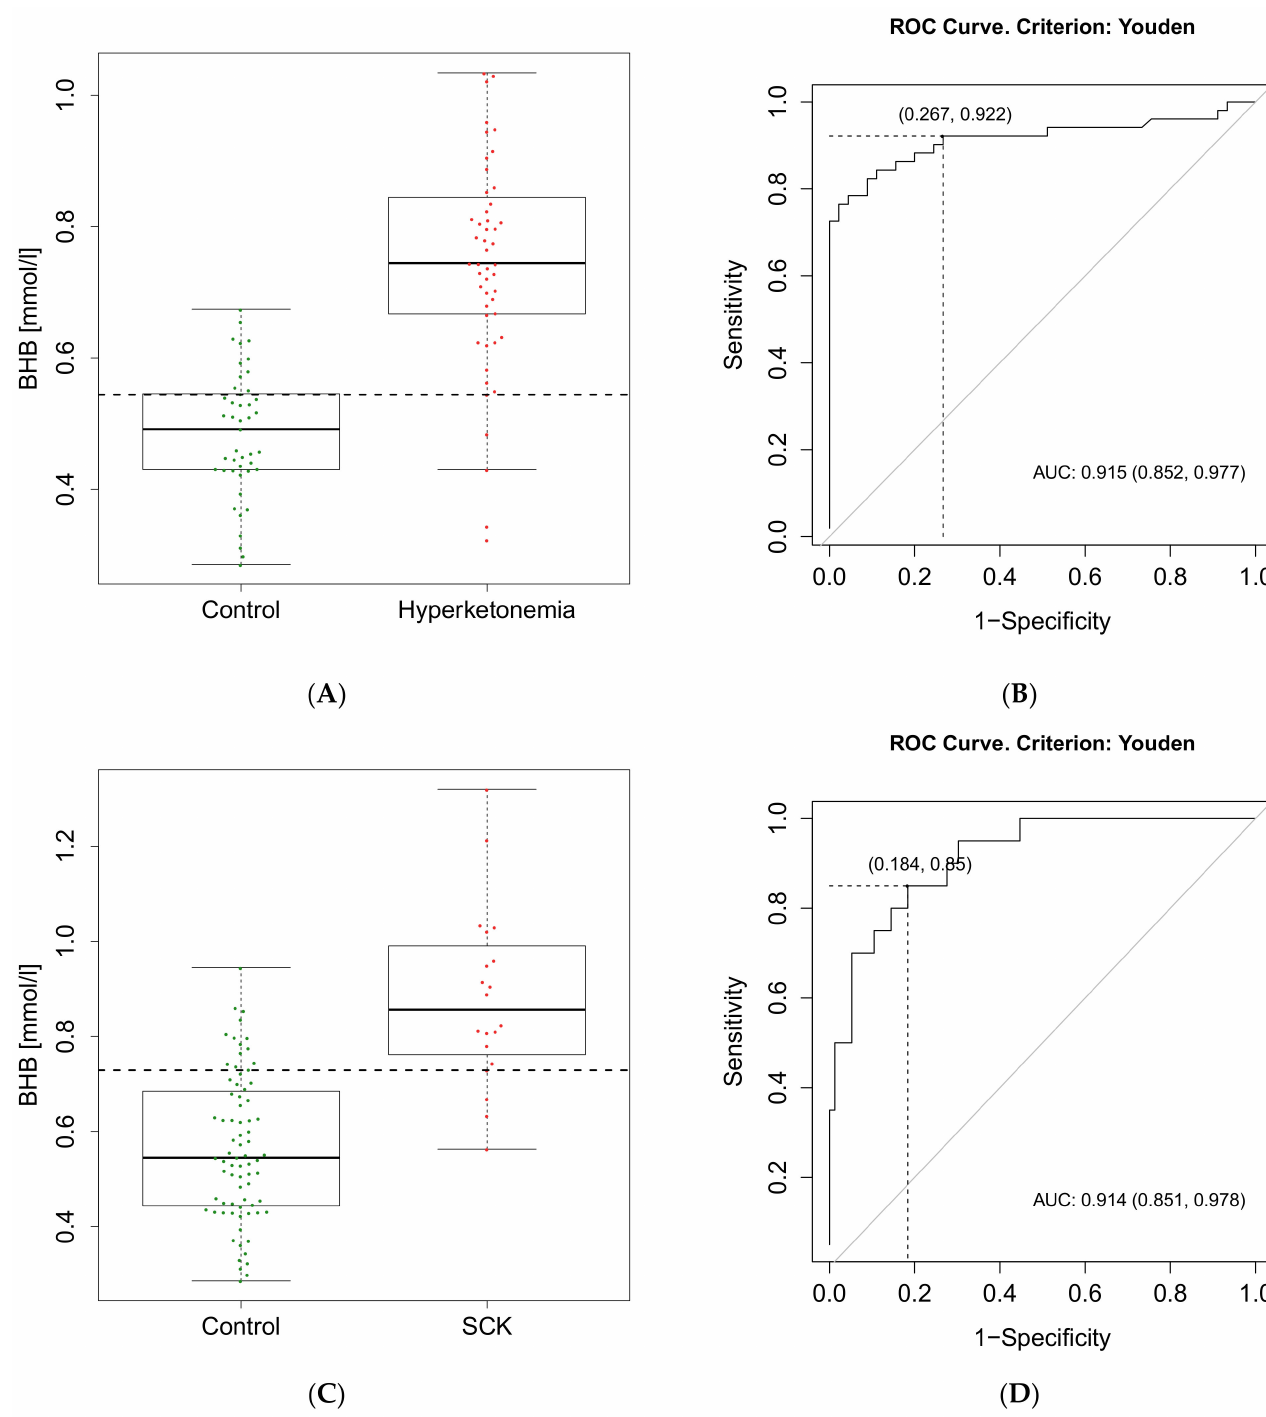
Figure 4. Data on the prognostic classifier for hyperketonemia and subclinical ketosis. ( A ) Boxplot of beta-hydroxybutyrate (BHB) concentrations on the 10th day p.p. for control (BHB ≤ 0.8 mmol/L) and hyperketonemia group (BHB > 0.8 mmol/L); ( C ) Boxplot of BHB concentrations on the 10th day p.p. for control (BHB ≤ 1.2 mmol/L) and SCK group (BHB > 1.2 mmol/L). Dots represent individual measurements. Dashed lines indicate calculated cut-off value (BHB = 0.54 mmol/L) for hyperke- tonemia and (BHB = 0.73 mmol/L) for SCK classification with the highest area under the curve (AUC); Receiver operating characteristic (ROC) curve for BHB concentration on the 10th day p.p. for hyperketonemia ( B) and SCK ( D ). Optimal cut-off point was calculated based on the Youden’s index. AUC: area under the